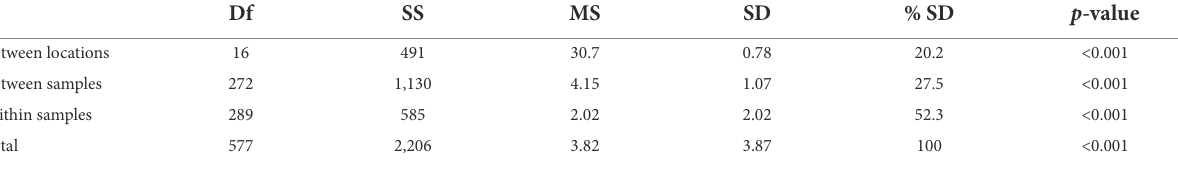
TABLE 2 Analysis of molecular variance (AMOVA).